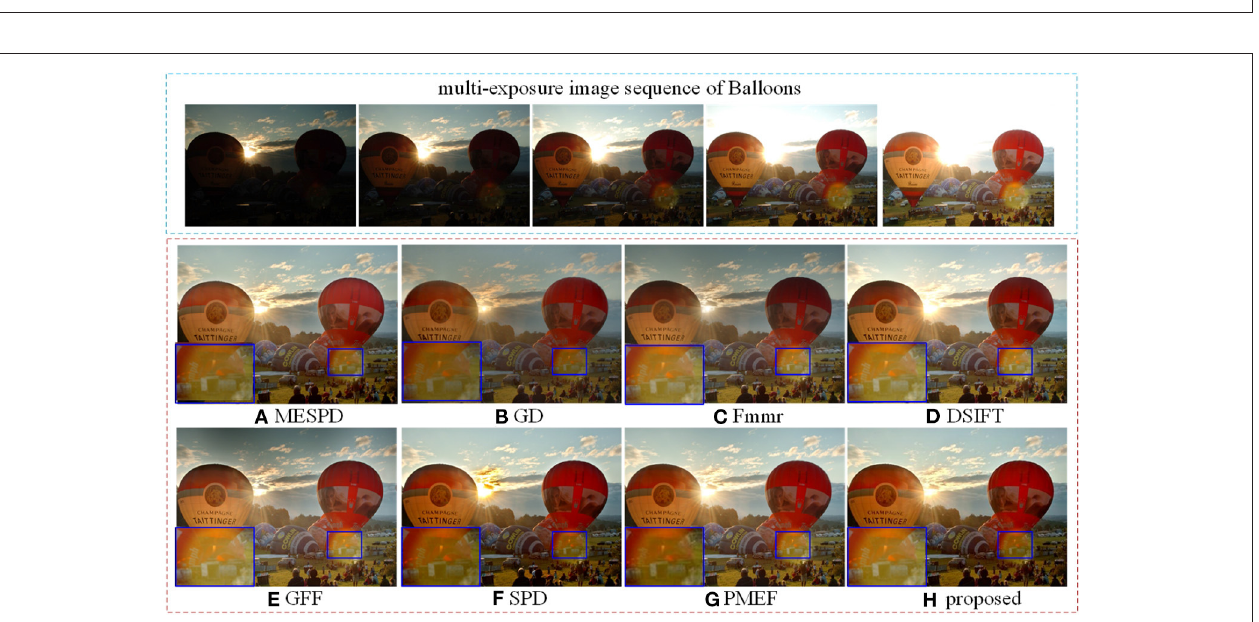
FIGURE 4 | Comparison of Ballons scene experiment results of different methods.